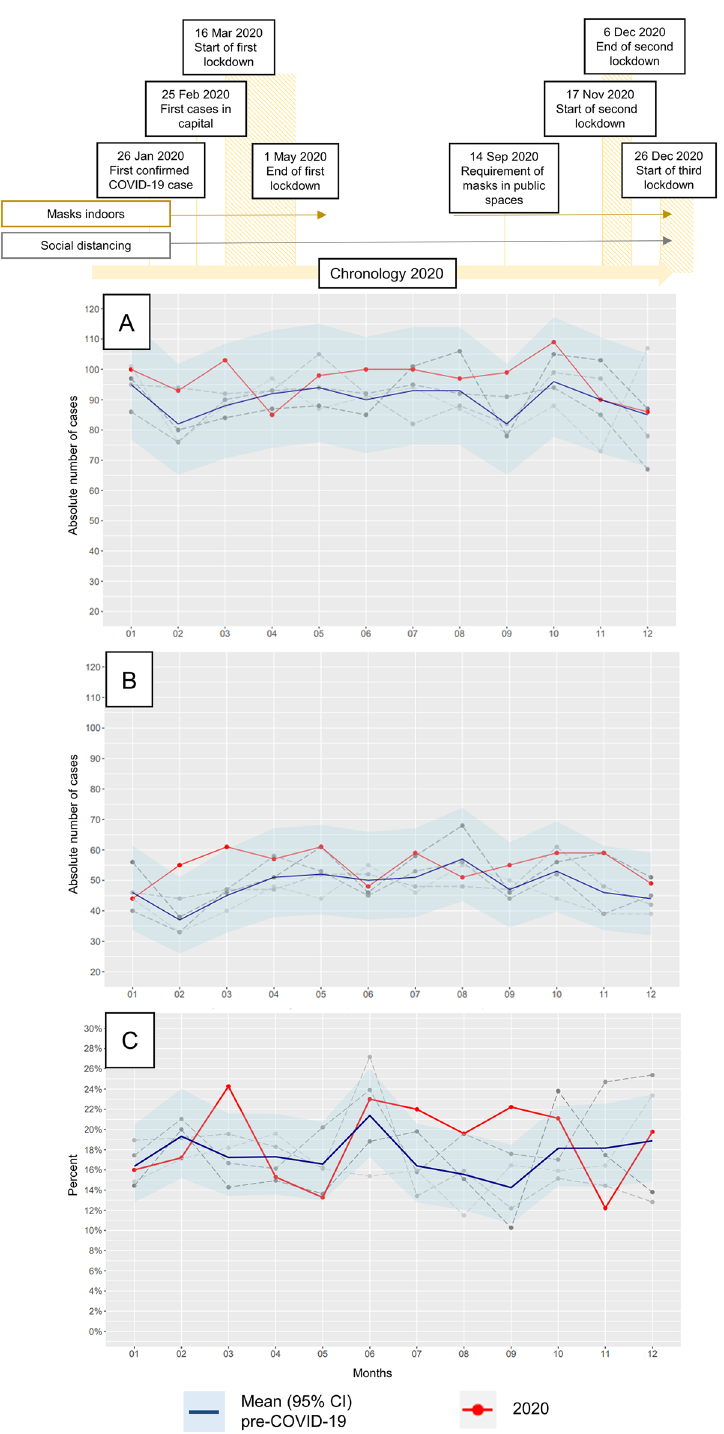
Figure 1. Chronology of COVID-19-measures and absolute number per month of stroke admissions ( A ), minor strokes (NIHSS ≤ 4) ( B ) as well as of rate per month of stroke patients with receiving i.v. thrombolysis ( C